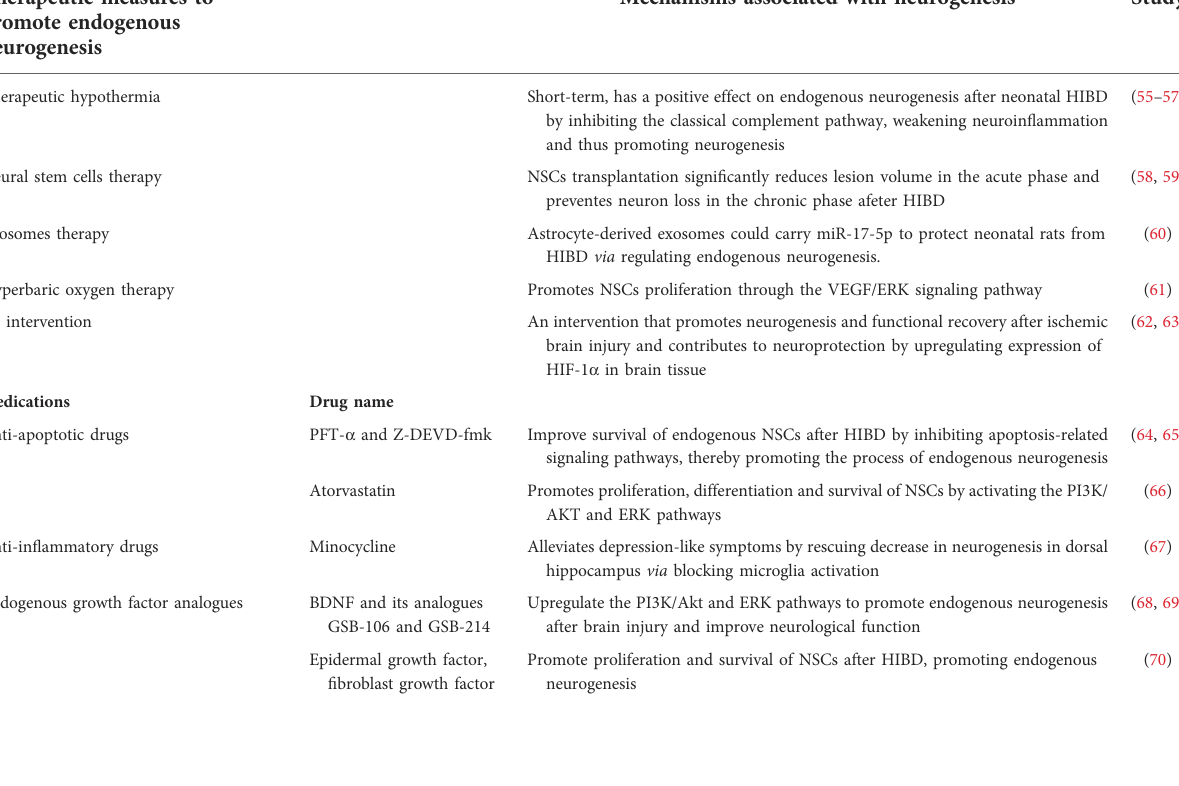
TABLE 1 Therapeutic approaches to promote endogenous neurogenesis and its mechanisms. HIBD, Hypoxic-ischemic brain damage; NSCs, Neural stem cells; EE, Enriched environment; PFT- α , Pi fi thrin- α ; BDNF, Brain-derived neurotrophic factor; VEGF, Vascular endothelial growth factor. Therapeutic measures to promote